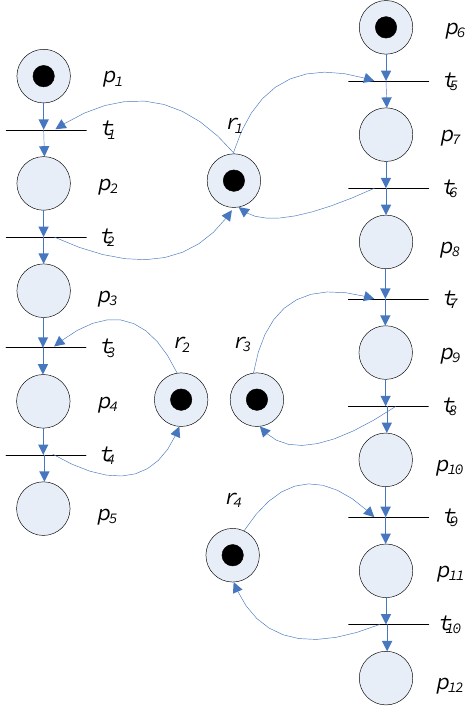
Figure 2. The firing time of each transition of G in Figure 3 is as follows: